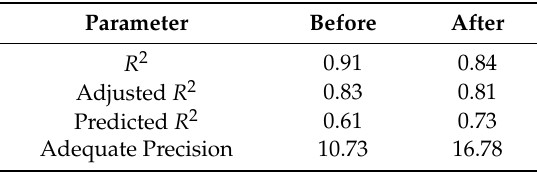
Table 10. R 2 parameterformaximumroughnessheight(Sz)modelbeforeandafterthebackwardelimination. Parameter Before